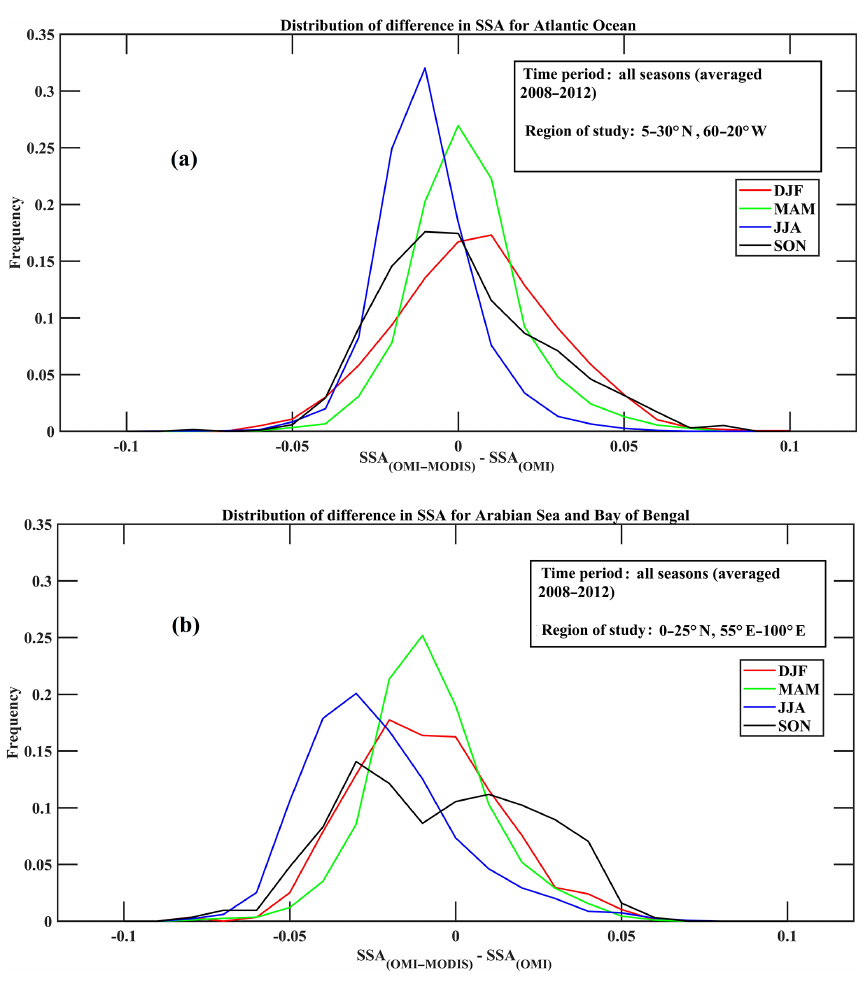
Figure 3. Distribution of the difference in SSA for all seasons averaged over the period from 2008 to 2012 over (a) the Atlantic and (b) the Arabian Sea and the Bay of Bengal. It can be seen that 80% of the difference in SSA retrievals was within the ± 0 . 03 range over the Atlantic Ocean, whereas over the Arabian Sea and Bay of Bengal the retrievals agreed well during the MAM season when the region was influenced by